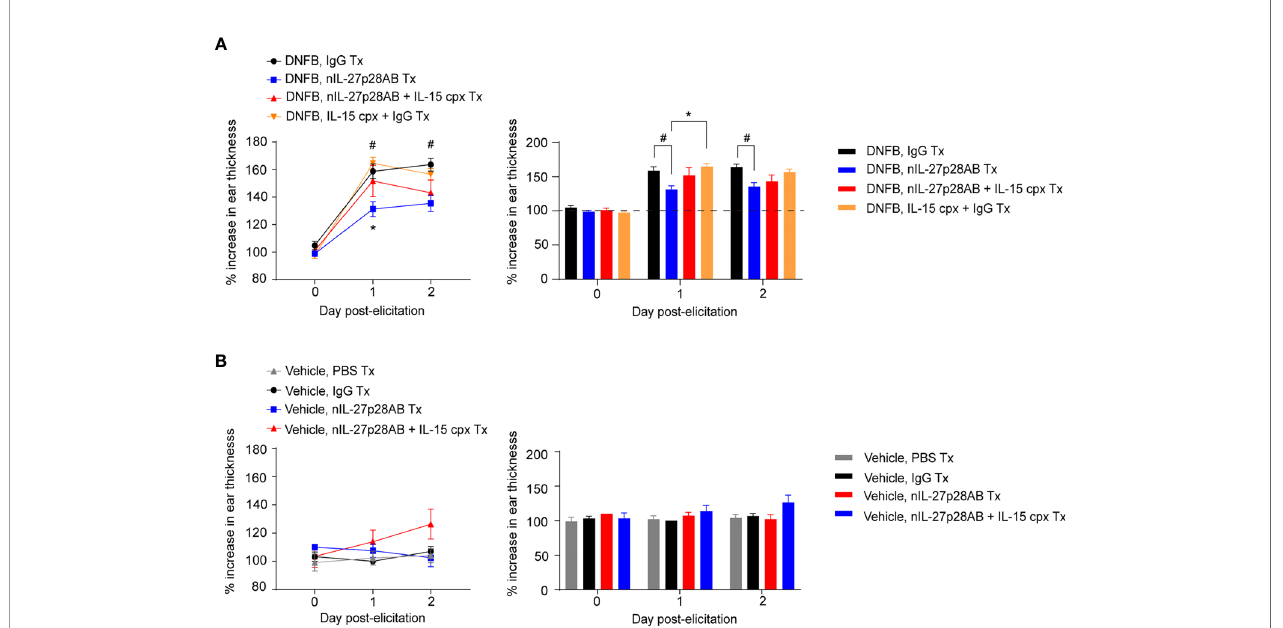
FIGURE 6 | IL-15 restores skin in fl ammation in mice treated with neutralizing IL-27 antibody (nIL-27p28AB). (A, B) Wild-type (WT) mice were sensitized and elicited with (A) DNFB or (B) vehicle and treated with nIL-27p28AB, nIL-27p28AB + IL15 complex (cpx) (IL-15 + IL-15R a ), IL-15 cpx + IgG, or IgG at day 7 after the fi rst ear elicitation. 2 days later, the mice were re-elicited with DNFB on the ear. Ear swelling was measured daily and is depicted as mean ± SEM from at least 3-4 mice per group, # and *p < 0.05 (ANOVA). # symbolizes the difference between IgG and nIL-27AB. * symbolizes the difference between nIL-27AB and IL-15 +